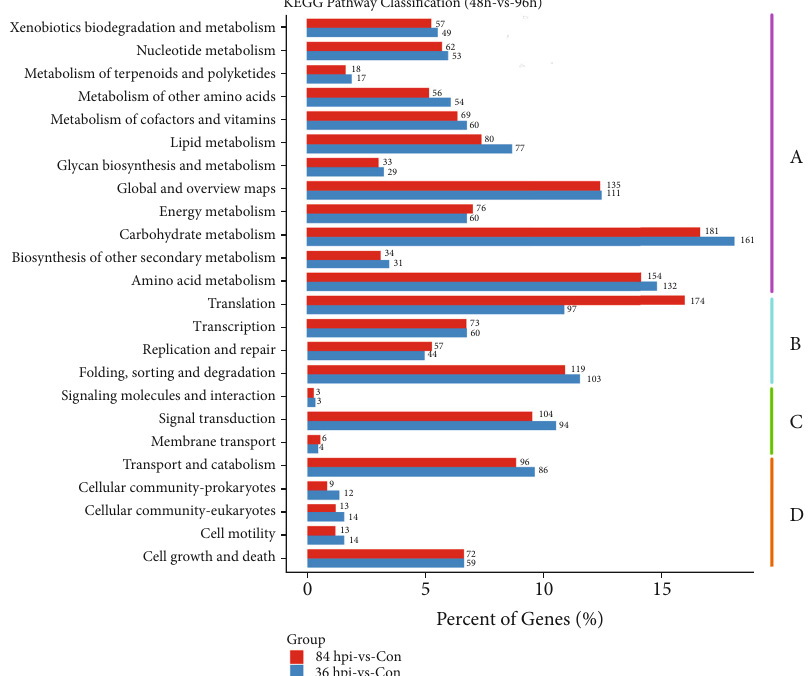
Figure 4: KEGG enrichment analysis of DEGs. The DEGs were clustered into four categories. (a) Metabolism. (b) Genetic information processing. (c) Environmental information processing. (d) Cellular processes. The y -axis has descriptions of the corresponding KEGG